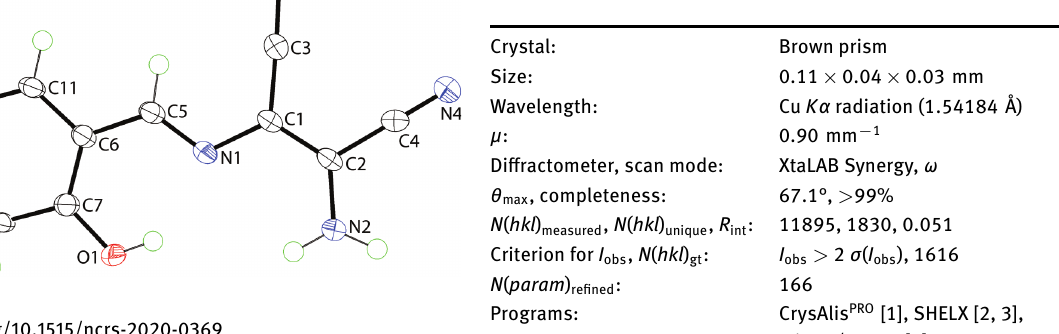
Table 1: Data collection and handling.